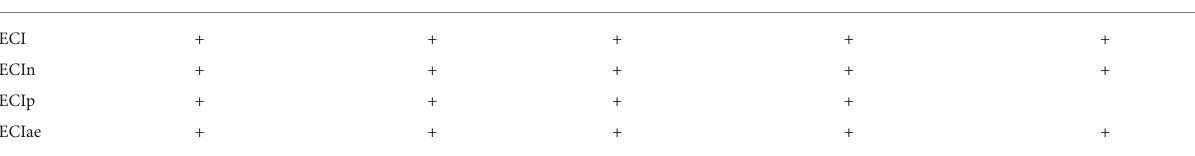
TABLE 8 Summary of the associations between emotional creativity and indicators of adaptive innovations presented in Tables 4 – 7